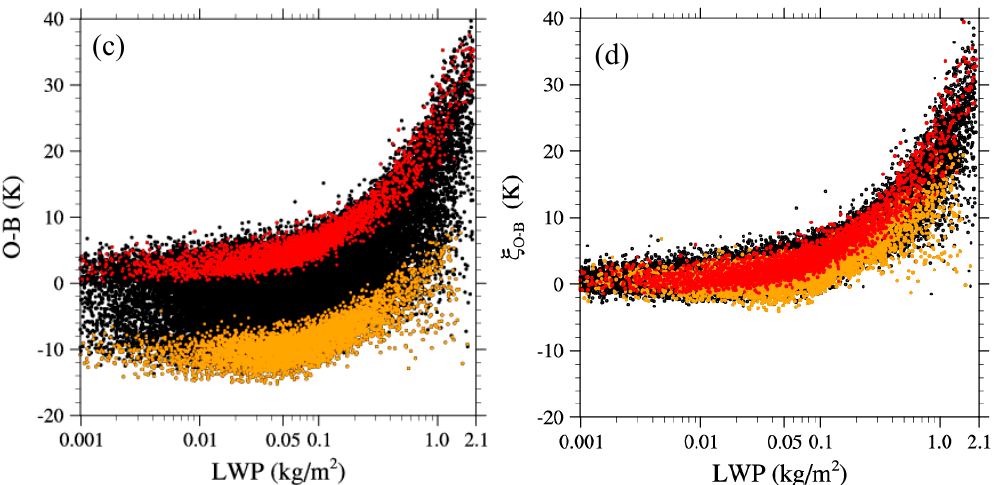
Figure 9. Scatterplots of O-B (left panels) and ξ O − B (right panels) for ( a , b ) collocated FY-3C MWTS-2 channel 1 and ( c , d ) MetOp-B AMSU-A channel 3 versus LWP (unit: kg m − 2 ) over oceans from ascending nodes on 15 July 2014. In red and orange are FOVs at nadir and at the largest scan angle, respectively.